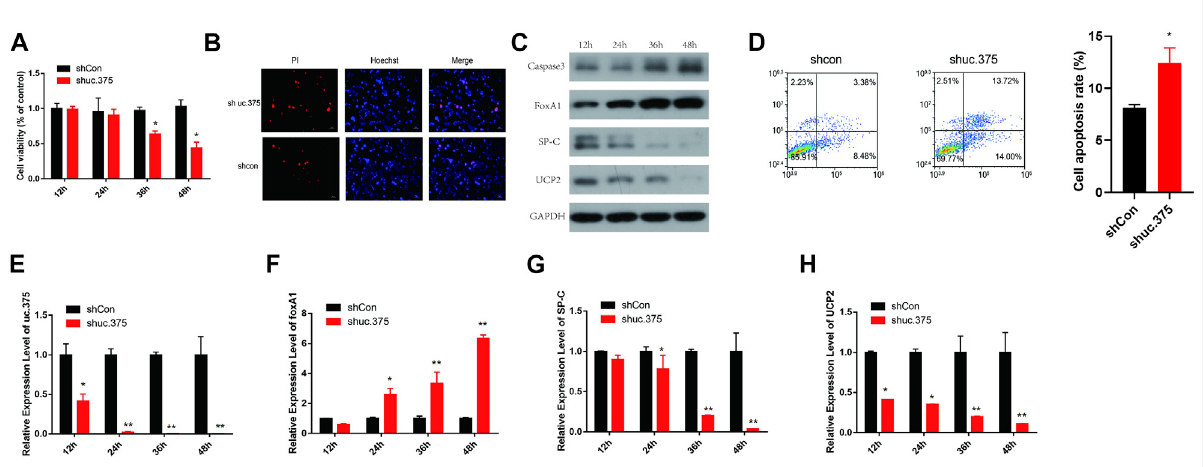
FIGURE 2 Theeffectofuc.375silencingonMLE12cellsfunctionandFoxA1 expression. (A) TheproliferationactivityofMLE12cellswasdetectedbyCCK- 8assay. (B) ThecellapoptosiswasdeterminedbyHoechst/PIstaininginMLE12cells. (C) Theproteinlevelsofcaspase3,FoxA1,SP-CandUCP2were investigatedbywesternblotinMLE12cells. (D) ThecellapoptosiswasdeterminedusinglowcytometryassayinMLE12cells.E-H.TherelativemRNA expression levels of uc.375, FoxA1, SP-C and UCP2 were detected by qRT-PCR in MLE 12 cells. * p < 0.05, ** p < 0.01 vs. shCon.